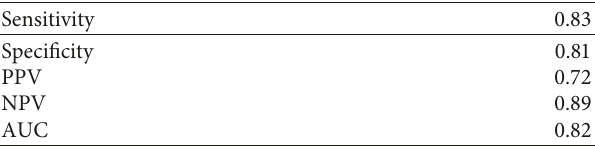
Figure 3: Mean curve (25th and 95th percentile) of the pressure registered by CompuFlo ® in the case of false loss of Table 1: Sensitivity, specificity, positive predictive value (PPV), negative predictive value (NPV), and area under the curve (AUC) concerning the ability of CompuFlo ® instrument pressure patterns to differentiate the true loss of resistance from the false loss of resistance.